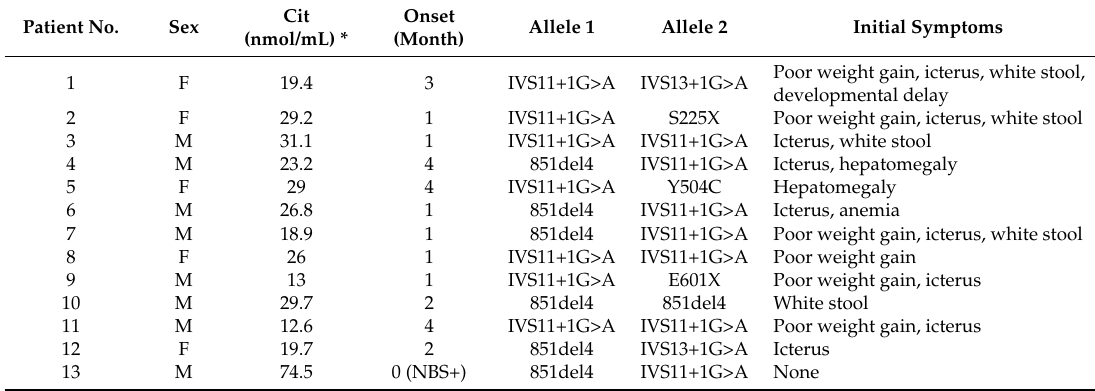
Table 1. Characteristics of patients with